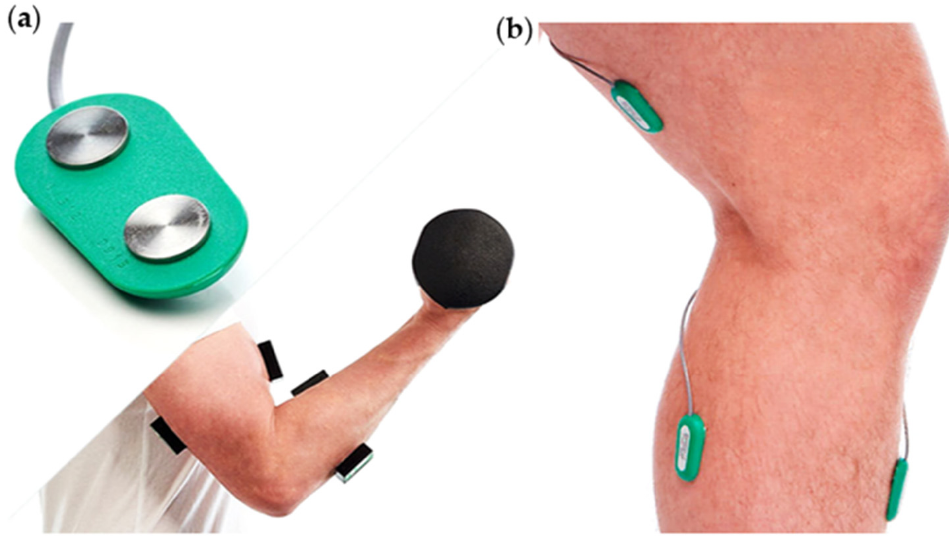
Figure 13. Biometrics Ltd. EMG sensors and systems are used extensively in the fields of ergonomics, sports science, and medical research, where measurements are commonly taken for a wide range of applications. The surface EMG sensor LE230 can be positioned in different body positions, such as arms ( a ) and legs ( b ) (Web-source: https://www.biometricsltd.com/surface-emg-sensor.htm arms ( a ), https://www.medicalexpo.com/prod/biometrics/product-123702-880665.html legs ( b ), every aspect related to the human subjects’ involvement has been taken into consideration by Biometrics Ltd.) (Image courtsey by Biometrics Ltd., Newport,